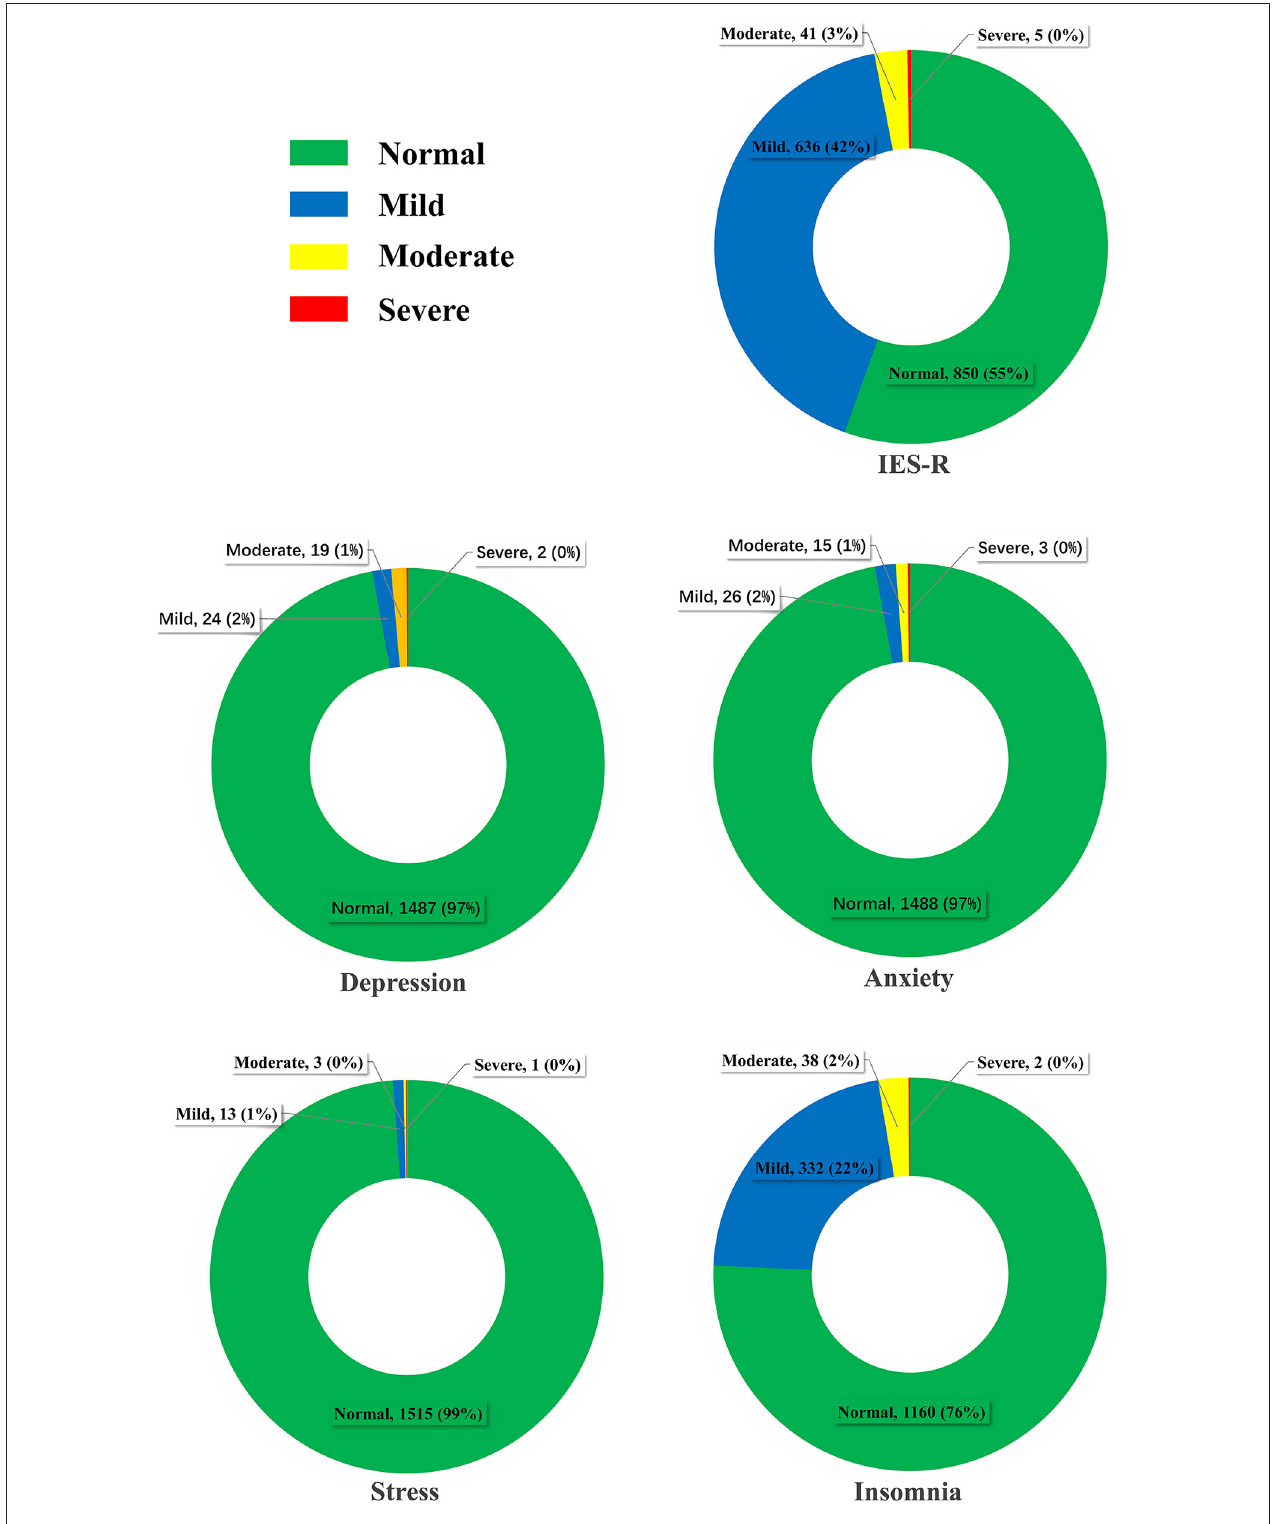
FIGURE 1 | Severity classifications of post-traumatic stress disorder, depression, anxiety, stress, and insomnia in nursing students.